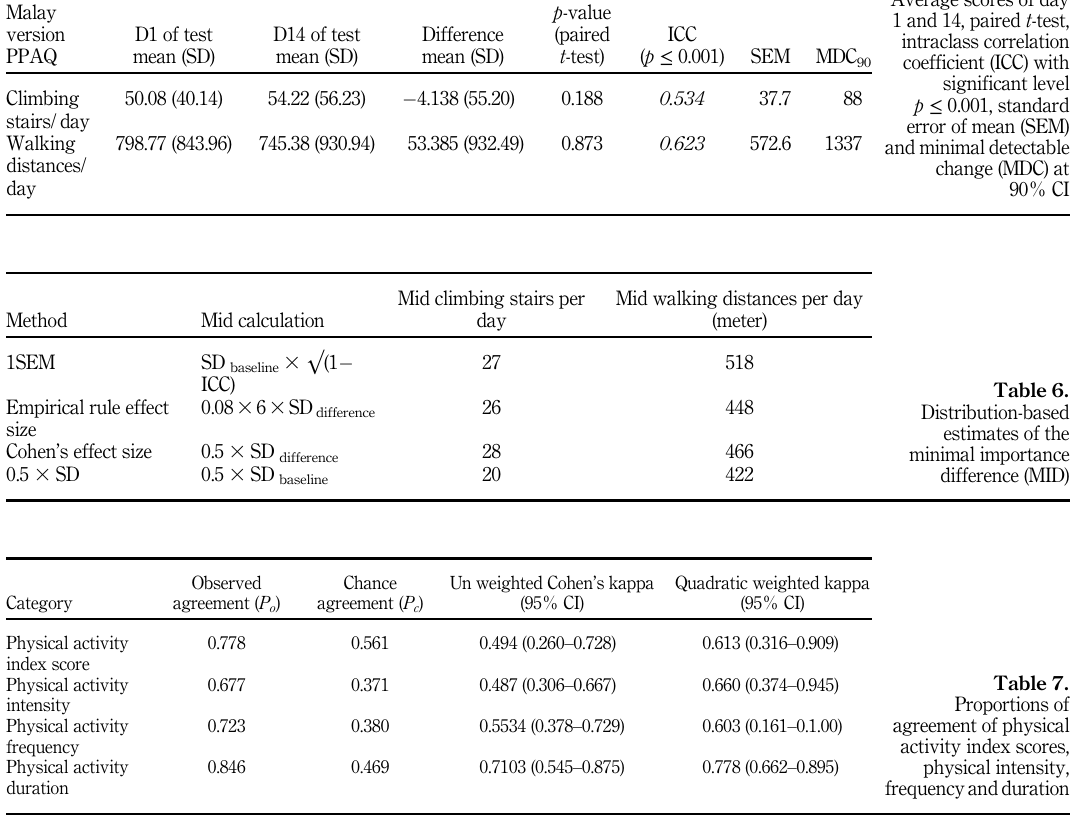
Table 5. Average scores of day